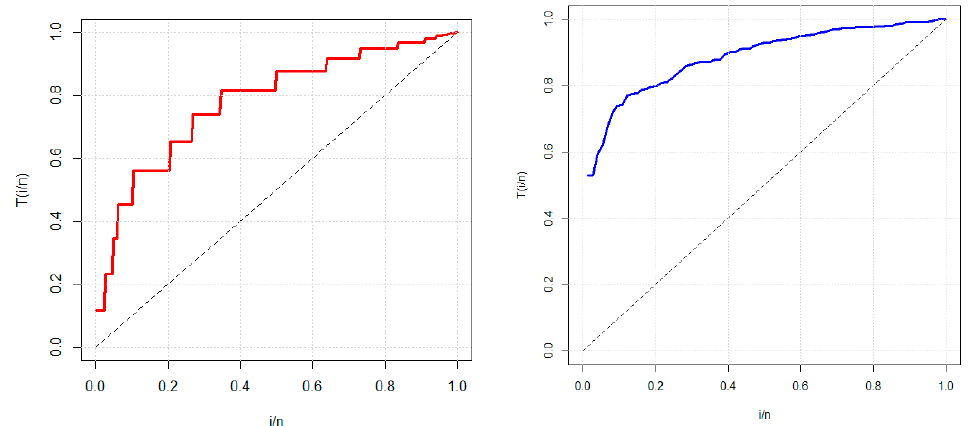
Figure 7. TTT plots of the data set I and II.